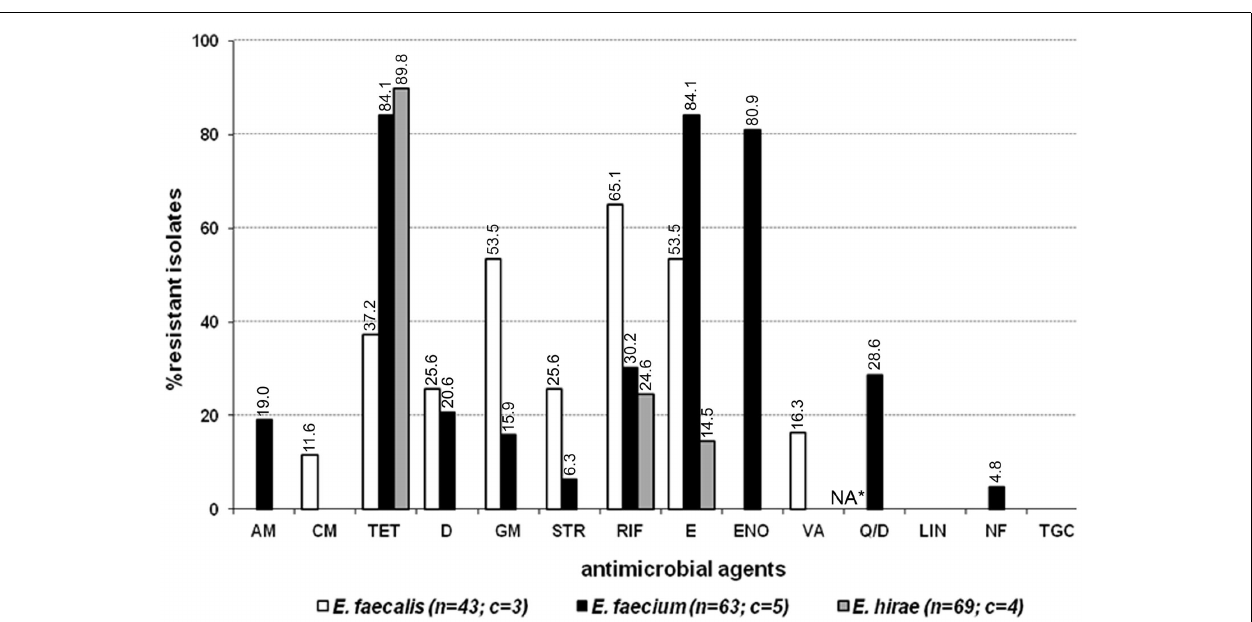
FIGURE 1 |Antimicrobial resistance profile of enterococci from the feces of six resident cats from small animal veterinary hospitals. AM, ampicillin; CM, chloramphenicol;TET, tetracycline; D, doxycycline; GM, gentamicin; STR, streptomycin; RIF, rifampicin; E, erythromycin; ENO, enrofloxacin;VA,